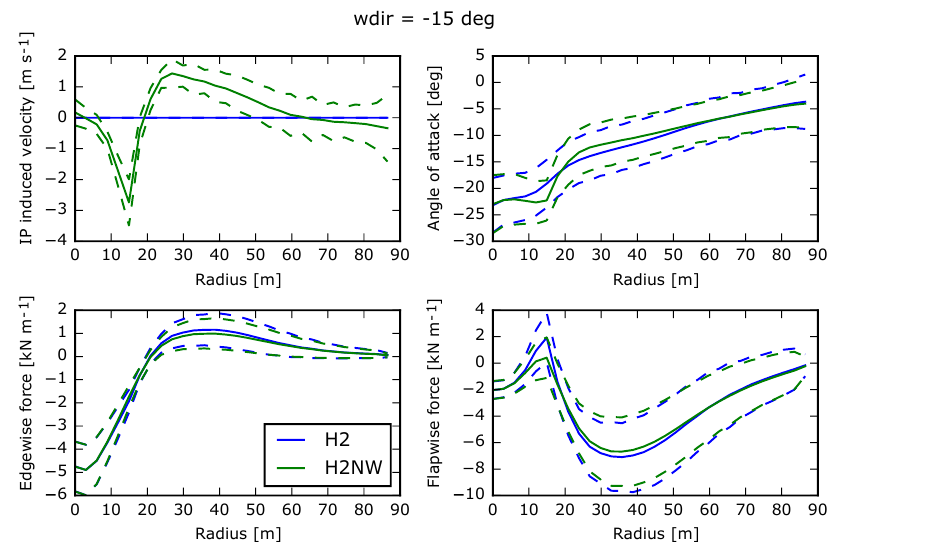
Figure 10. Distribution of induction, AOA, and loads for the upward-pointing blade. The mean values are shown as solid lines, and the dashed lines indicate the standard deviations; IP indicates in-plane.